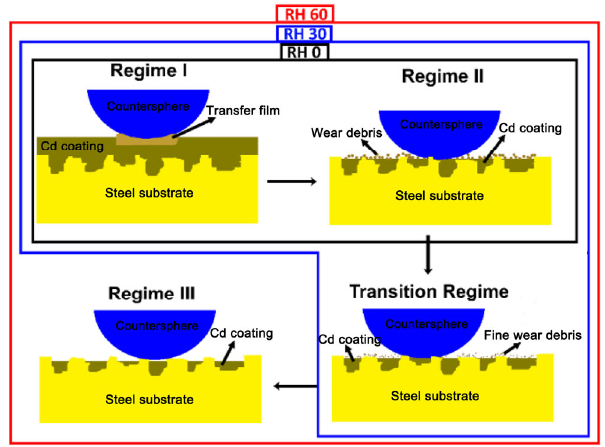
Fig. 19 Schematic representation of change in average CoF with change in relative